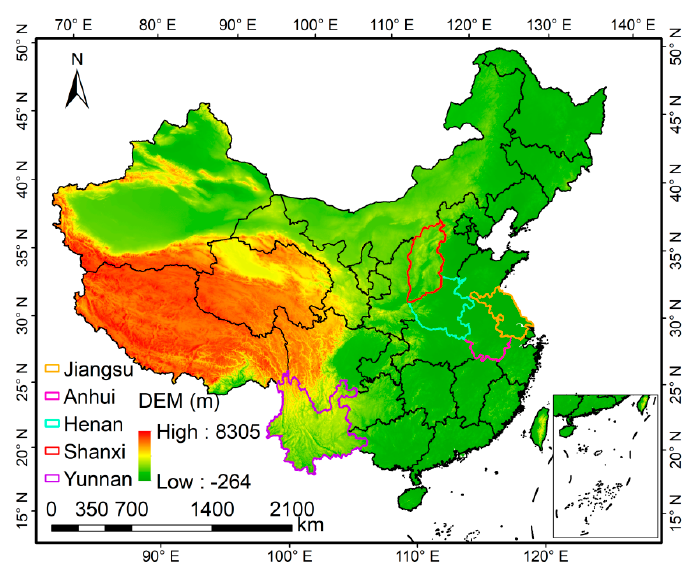
Figure 2. The study area: China and five provinces (Jiangsu, Anhui, Henan, Shanxi, Yunnan). The Digital Elevation Model (DEM) represents the landscapes of the study area. Synergy cropland mapping with various training sample sizes and synergy cropland mapping with different satellite-based maps were conducted in China. Synergy cropland mapping with various landscapes were conducted in five provinces.